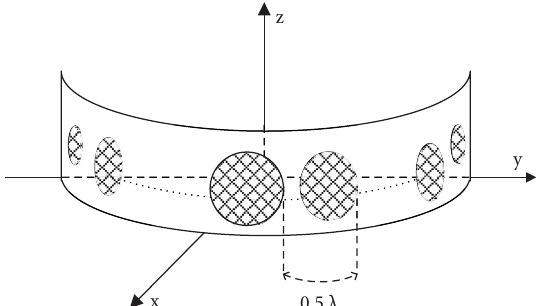
Figure 2: Dual-polarized semicircular patch antenna array.